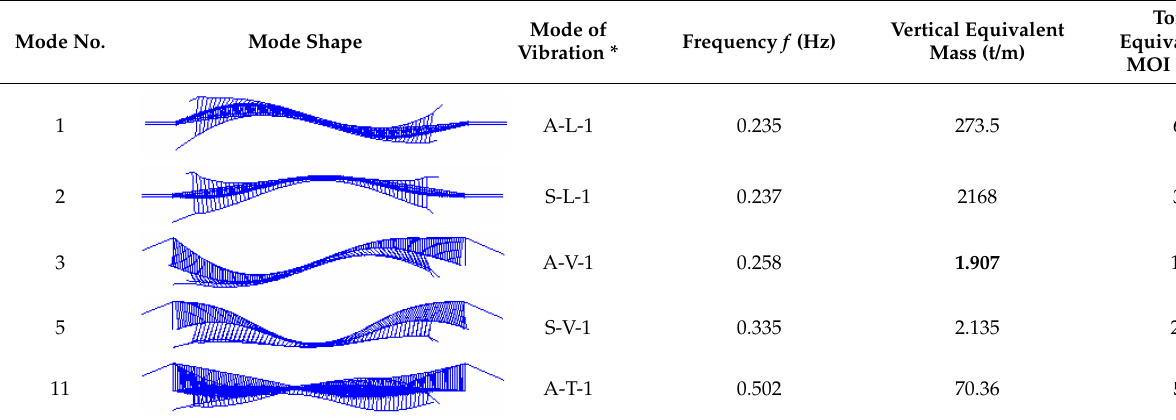
Table 2. Dynamic characteristics of some key modes of the